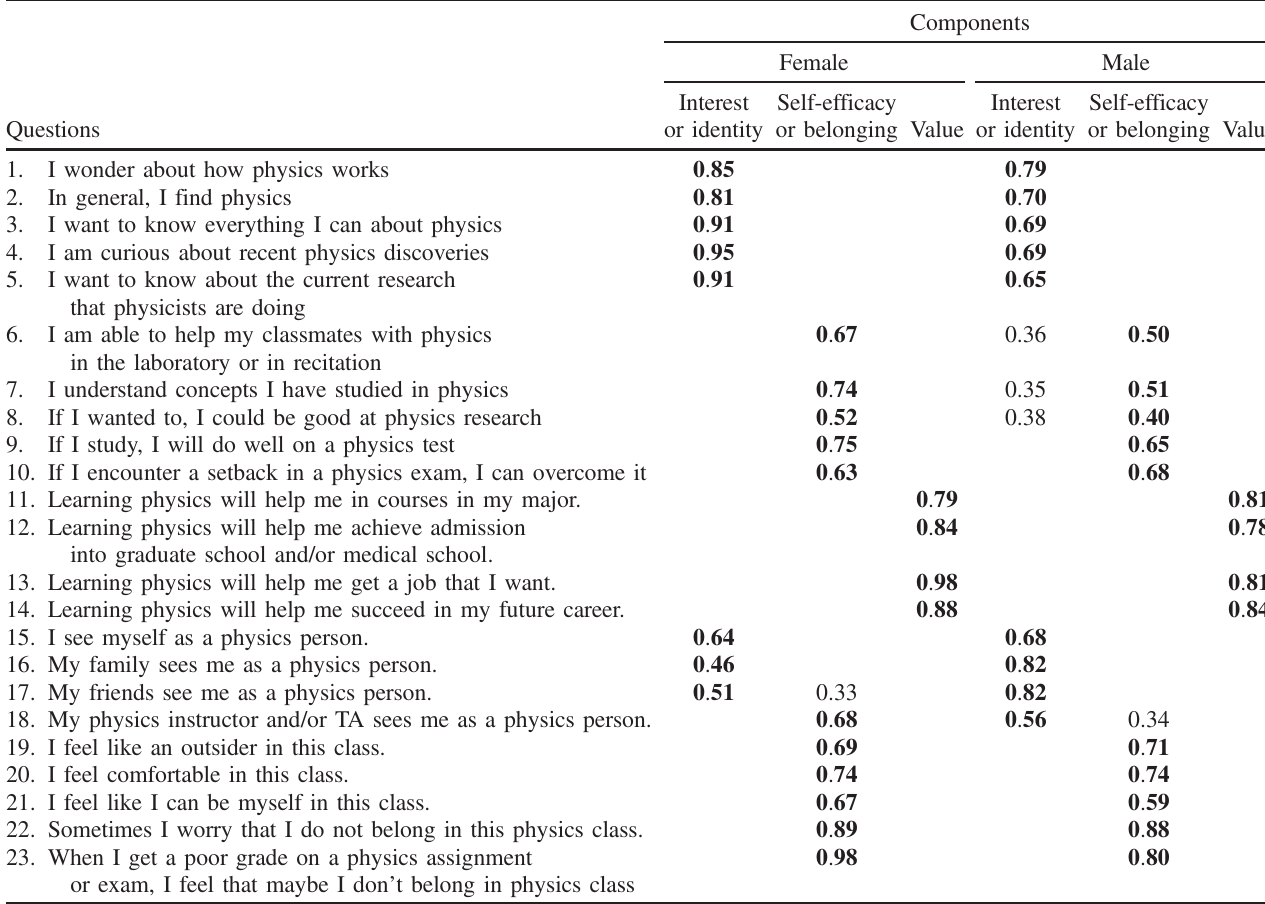
TABLE II. Factor loadings from the principle component analysis results for female and male students. Loadings > 0 . 4 are in bold. Loadings below 0.3 are